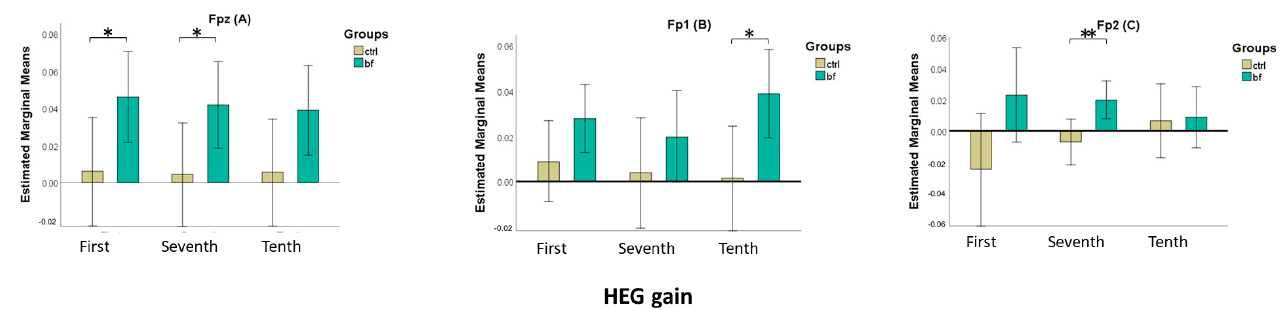
Figure 6. Bar chart showing the estimated marginal means (with 95% confidence intervals) for mean HEG gains by time session and by group, separated by site Fpz ( A ), Fp1 ( B ), and Fp2 ( C ) (*— p < 0.05, **— p < 0.01—F ‐ test derived from one ‐ way ANOVAs).